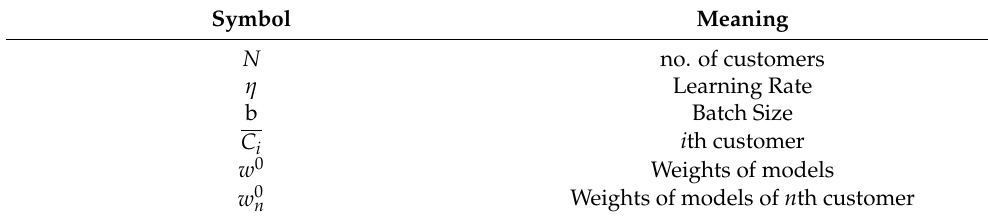
Table 2. Symbol representations.